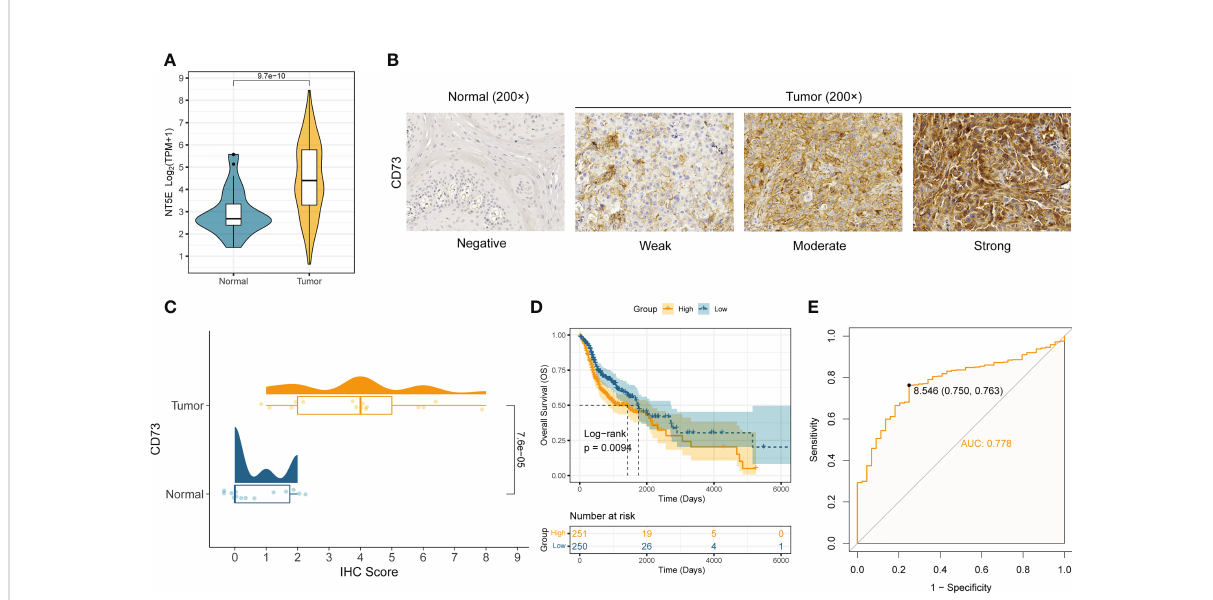
FIGURE 1 CD73 is elevated in HNSCC and indicates worse survival. (A) The comparison of NT5E mRNA expression between tumor and normal in TCGA- HNSC cohort. (B) Representative images of CD73 protein in HNSCC and normal tissues. (C) The distribution and statistical analysis of